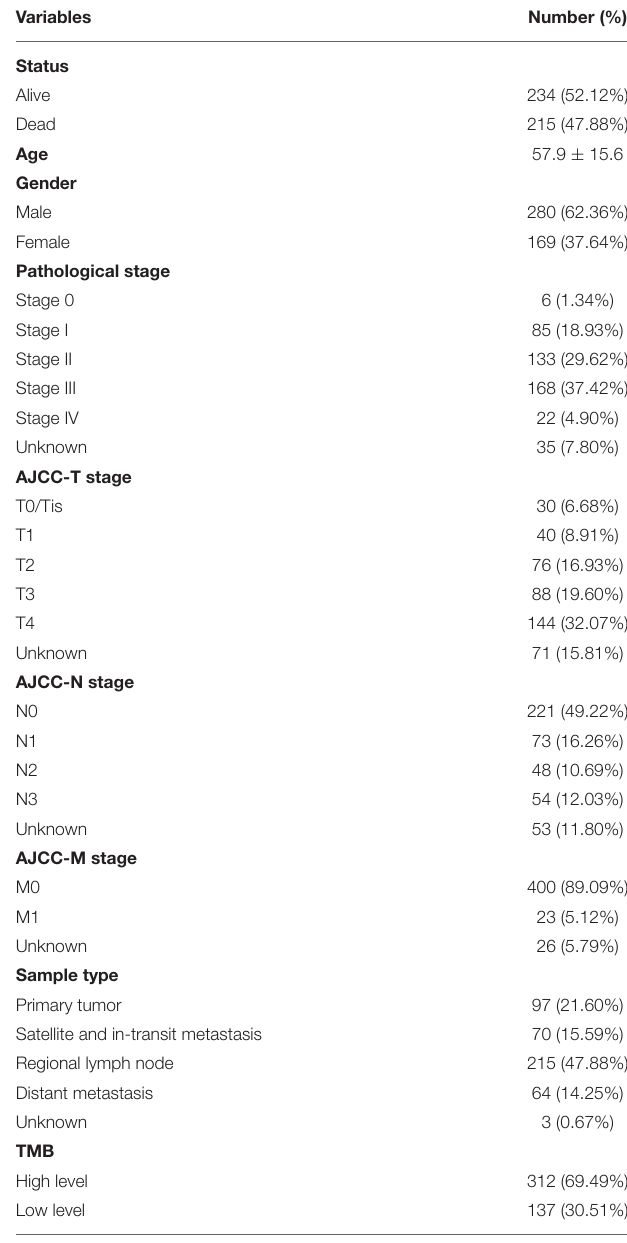
TABLE 1 | Clinical baseline of 449 melanoma patients in TCGA